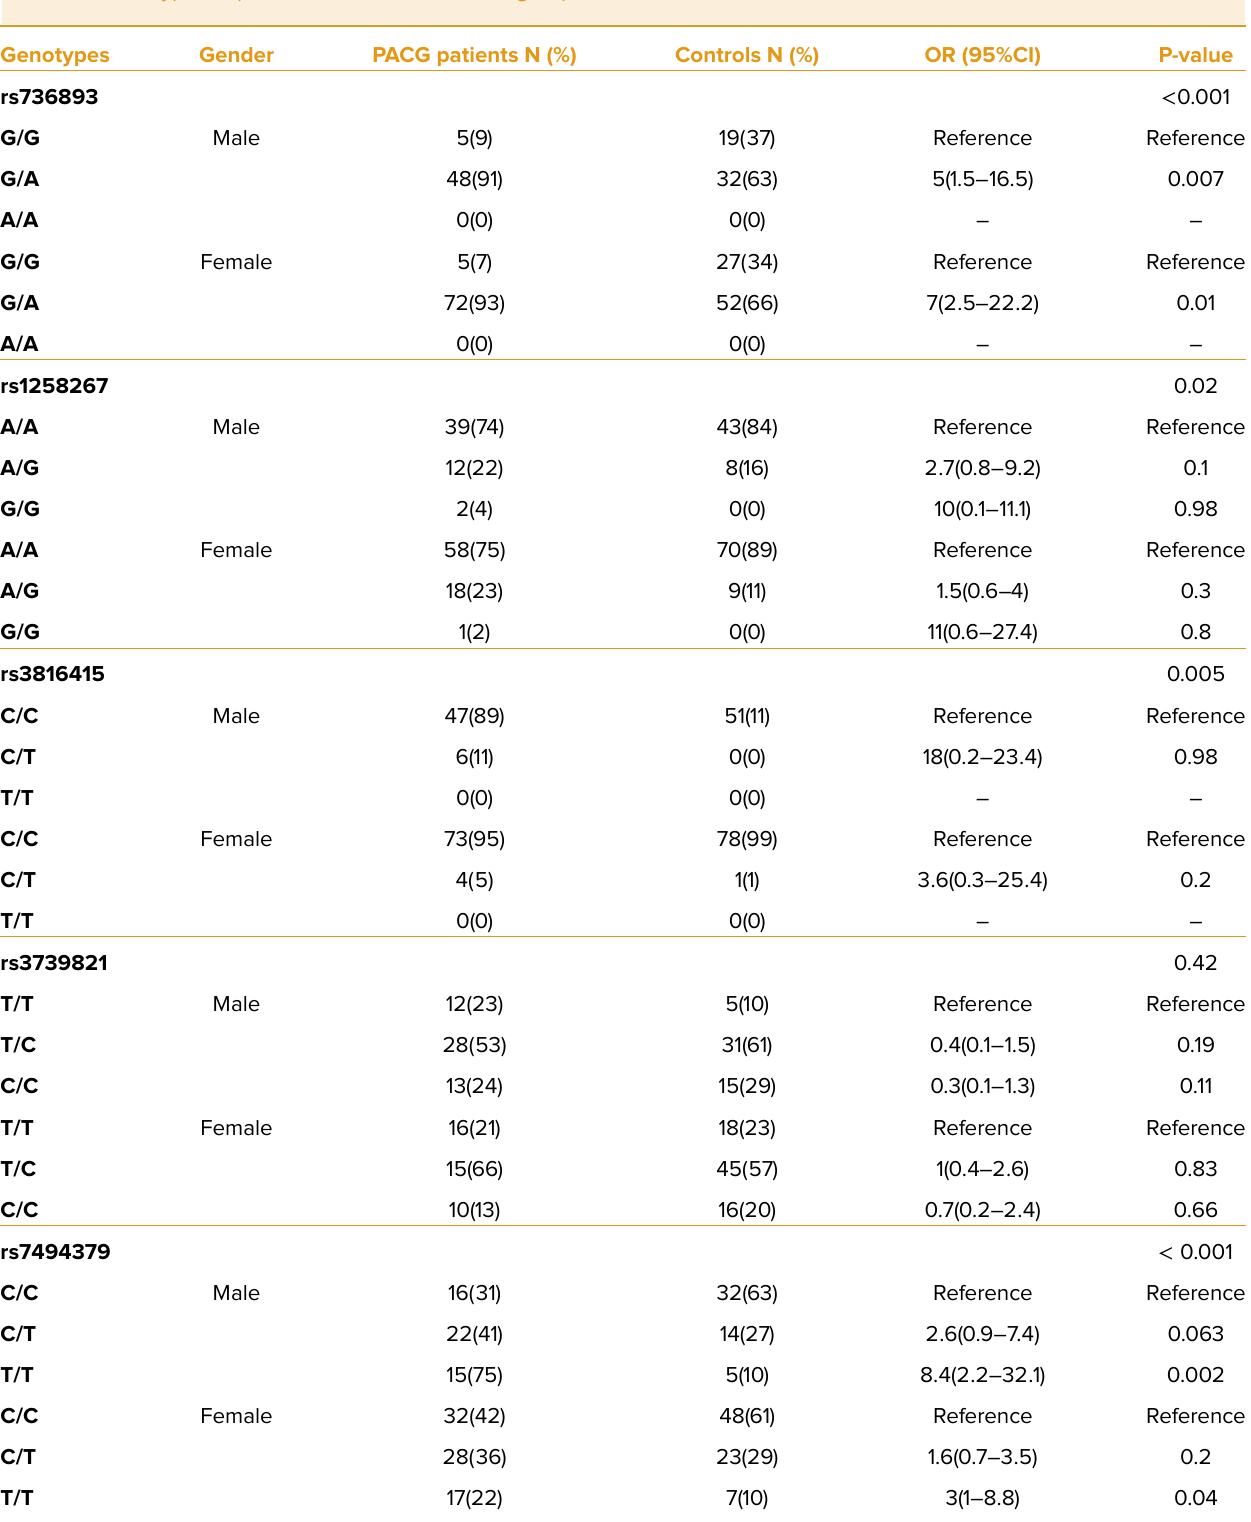
Table 4. Genotype frequencies in male and female